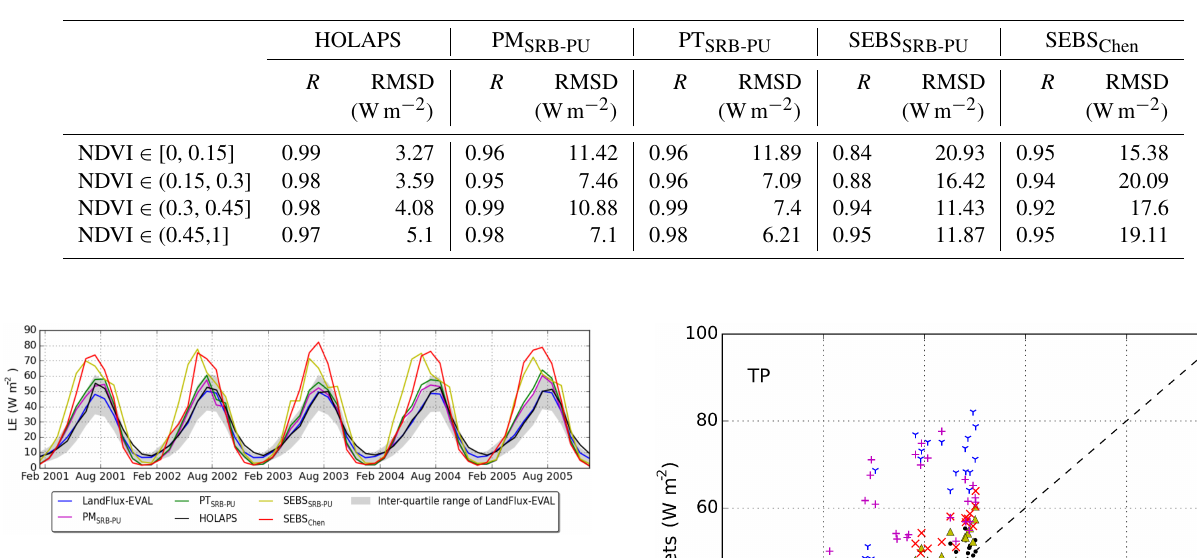
Figure 7. Temporal variability of the area-averaged LE for each dataset over the TP. The grey shadow displays the inter-quartile range between 25th percentile and 75th percentile of the LandFlux- EVAL multi-datasets ensemble.